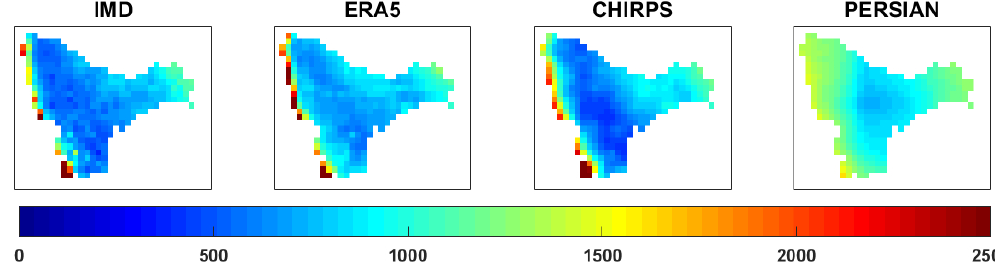
Figure 3. Spatial maps of average annual precipitation computed from IMD, ERA-5, CHIRPS, and PERSIANN-CDR datasets.